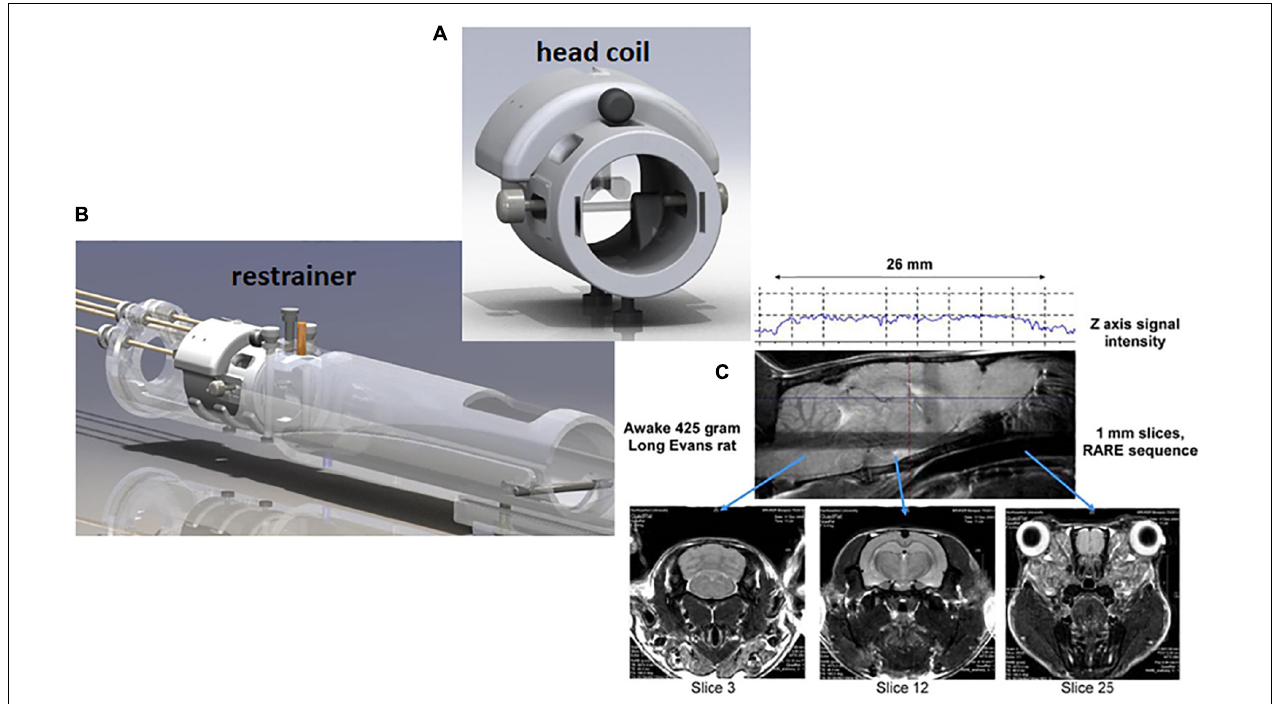
FIGURE 1 | Rat imaging system. Shown are a radiofrequency coil (A) and restraining system (B) for awake rat imaging. A quadrature transmit/receive volume coil is built into the head restrainer to optimize space fitting, signal-to-noise, and field homogeneity. The design of coil allows for whole brain imaging from olfactory bulbs (slice 25) to cerebellum (slice 3) (C)